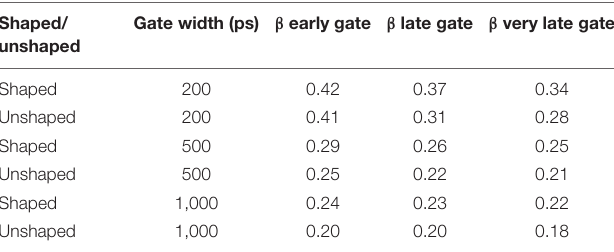
TABLE 1 | β as a function of gate start time and gate width for shaped (300ps FWHM) and unshaped pulses ( ∼ 600 ps FWHM). Shaped/